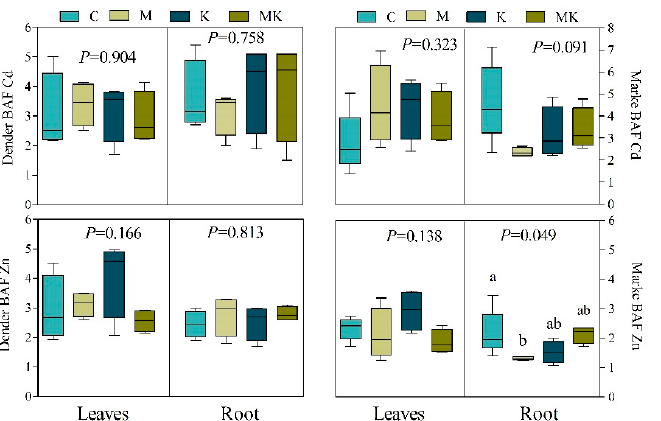
Figure 6. Bioaccumulation factors (BAF) for Cd and Zn calculated after 6 weeks of growth in trace elements polluted soil in leaves and roots of cuttings of the Populus cultivars ‘Dender’ and ‘Marke’. Ctrl (control): non-inoculated cuttings; M: Methylobacterium sp. CP3 inoculation; K: Kineococcus endophyticus CP19 inoculation; M+K: Methylobacterium sp. CP3 and Kineococcus